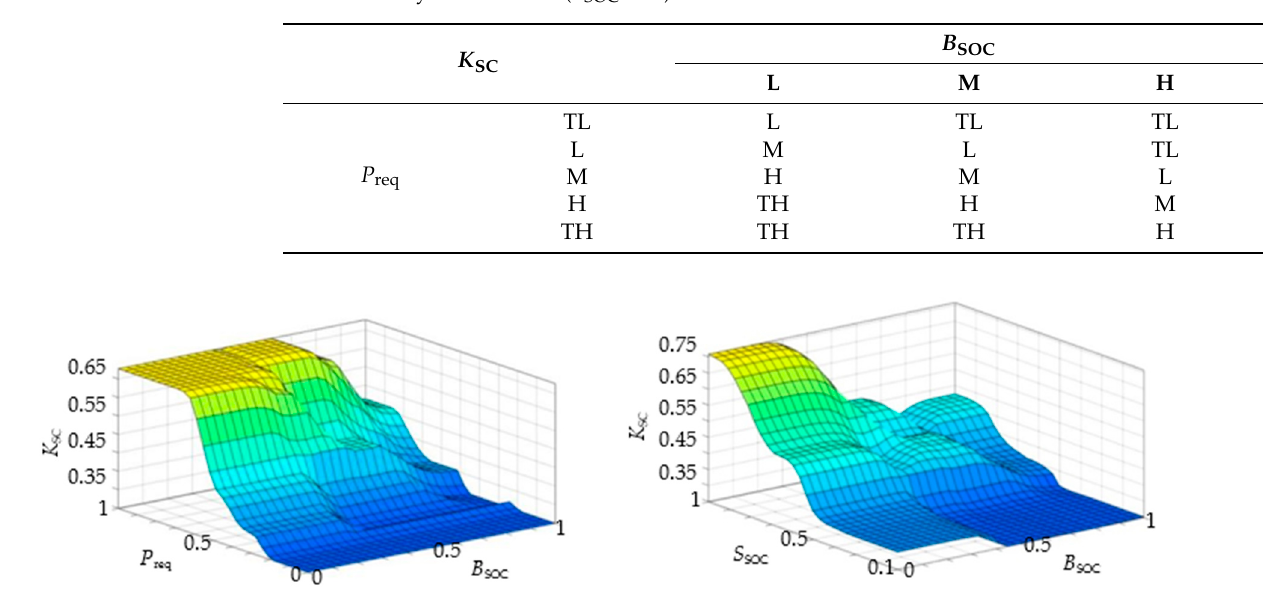
Figure 10. Relationship among S SOC , B SOC , P req and K SC .